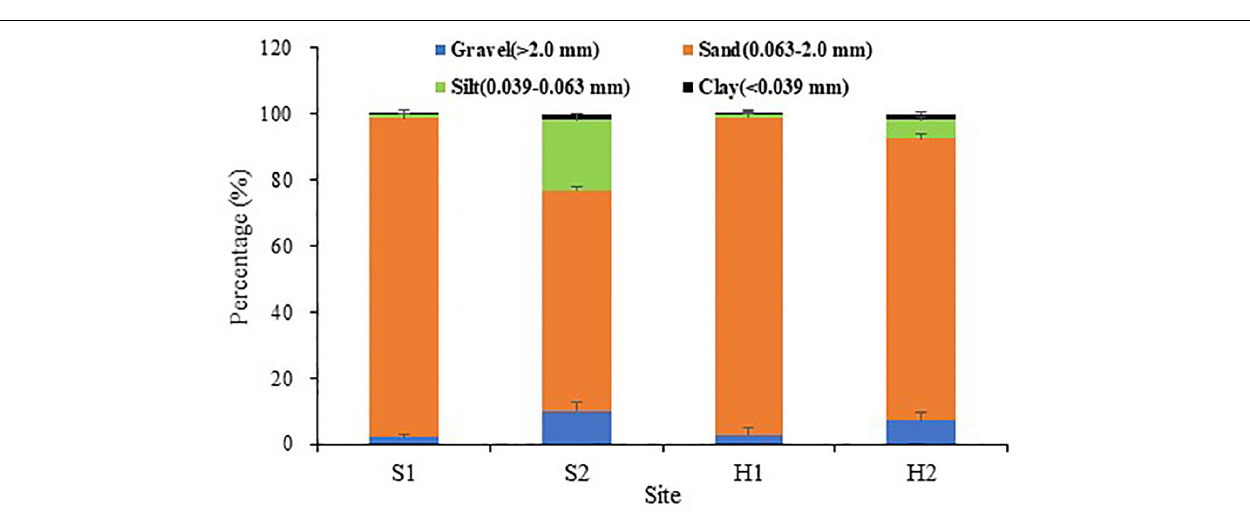
Frontiers in Marine Science |